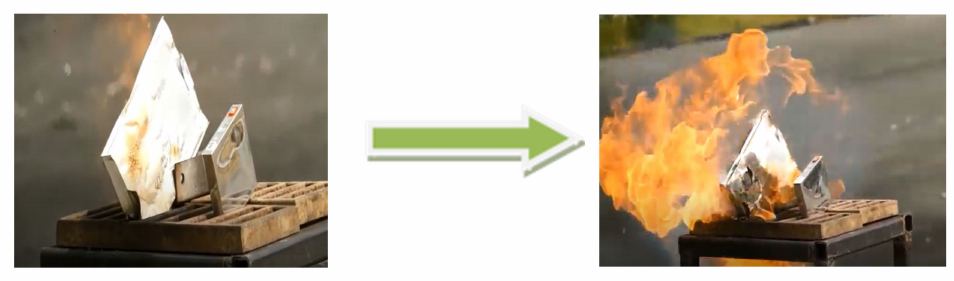
Figure 16. Exp. A.2